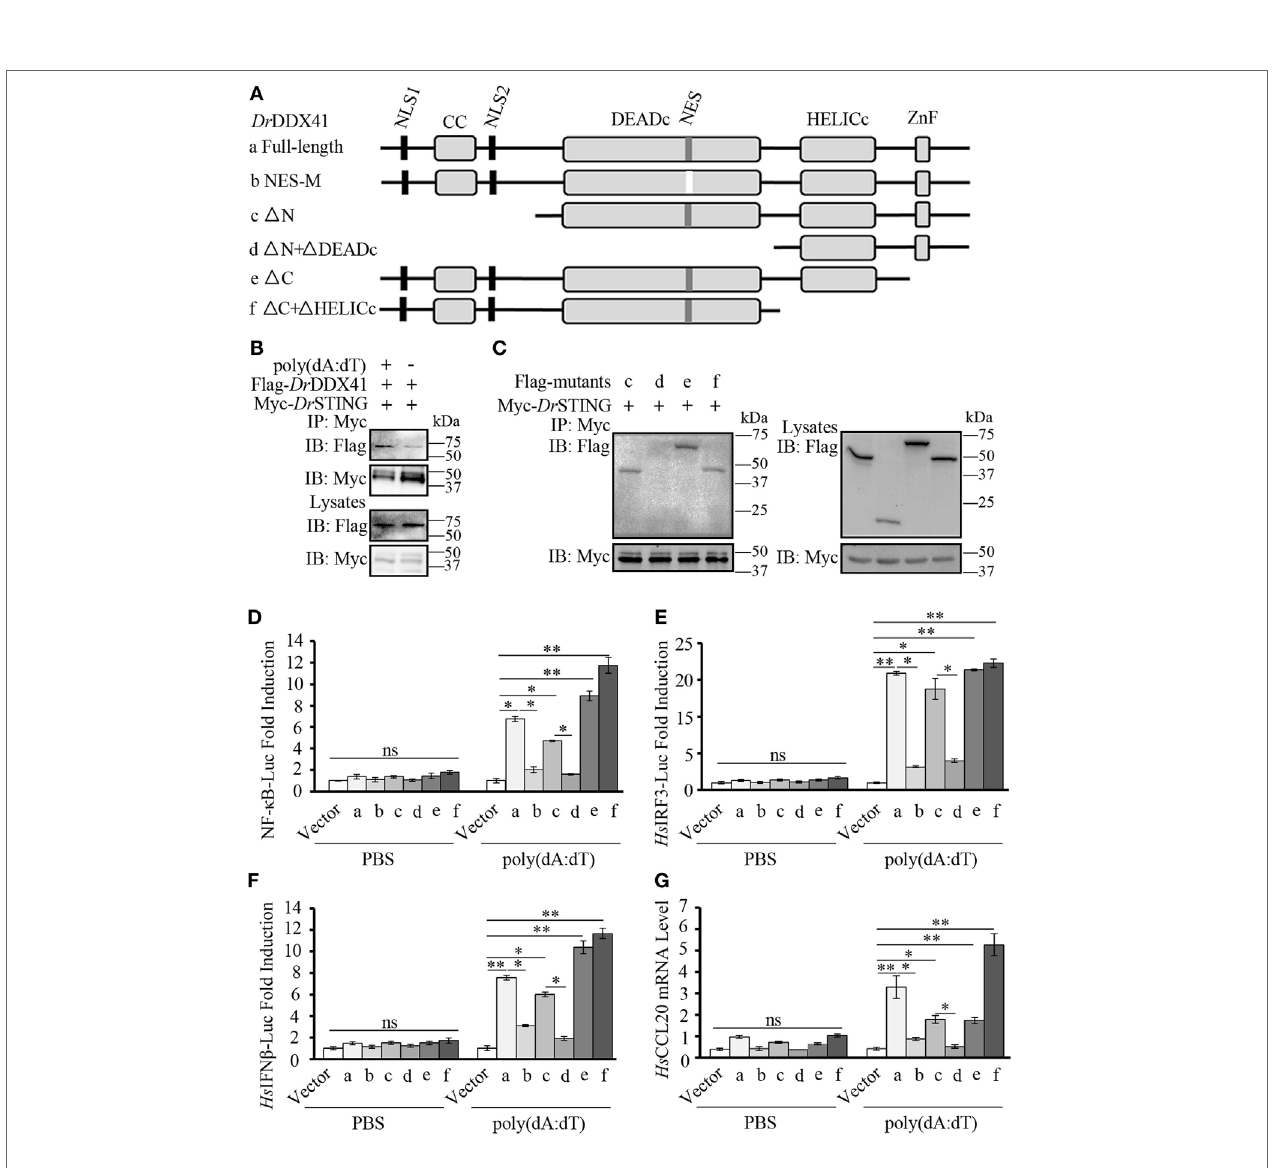
FigUre 8 | Involvement of Danio rerio DDX41 ( Dr DDX41) in Danio rerio STING ( Dr STING)– Danio rerio STAT6 ( Dr STAT6)-mediated Danio rerio CCL20 ( Dr CCL20) expression . (a) Quantitative RT-PCR (Q-RT-PCR) analysis of Hs CCL20 in HEK293T cells transfected with increasing amounts (0, 200, and 400 ng/mL) of expression vectors for Dr DDX41 or Dr STING individually or expression vector for Dr STING (200 ng/mL) together with increasing concentrations (0, 200, and 400 ng/mL) of expression vectors for Dr DDX41 and stimulated with poly(dA:dT) (1 µg/mL) for 6 h. Data are representative of three independent experiments as mean ± SD (* p < 0.05; ** p < 0.01). (B) Q-RT-PCR analysis of Hs CCL20 in HEK293 cells transfected with increasing amounts (0, 200, and 400 ng/mL) of expression vectors for Dr DDX41, Dr STING or Dr STAT6 individually or expression vector for Dr STAT6 (200 ng/mL) together with increasing concentrations (0, 200, and 400 ng/mL) of expression vectors for Dr DDX41 or Dr STING and stimulated with poly(dA:dT) (1 µg/mL) for 6 h. Data are representative of three independent experiments as mean ± SD (* p < 0.05; ** p < 0.01). The bands in the upper-left denote the western blot analysis of the expression of Dr DDX41, Dr STING, and Dr STAT6 in HEK293 cells transfected with increasing amounts (0, 200, and 400 ng/mL) of corresponding vectors. (c) Dr STING coimmunoprecipitates with Dr STAT6 through the mediation of Dr DDX41 under poly(dA:dT) stimulation. (D) Q-RT-PCR analysis of Dr CCL20 mRNA levels in 24 hours post microinjection embryos microinjected with standard MO and PBS (US) or standard MO (Ctrl), Dr DDX41/ Dr STING/ Dr STAT6-MO, the targeted-MOs together with their corresponding mRNAs, and poly(dA:dT) (100 pg/embryo). Data are representative of three independent experiments as mean ± SD (* p < 0.05; ** p < 0.01). Standard loading was indicated by β -actin expression. (e) Q-RT-PCR analysis of Dr CCL20 mRNA levels in embryos microinjected with different combinations of Dr DDX41-MO ( Dr D-MO), Dr STING-MO ( Dr S-MO), Dr STAT6-MO ( Dr S6-MO), and their mRNAs (mR) for rescue, and poly(dA:dT) (100 pg/embryo). Each of the MOs and mRNAs was administered at 4 ng/embryo and 200 pg/embryo in each group. Data are representative of three independent experiments as mean ± SD (* p < 0.05; ** p < 0.01). Standard loading was indicated by β -actin